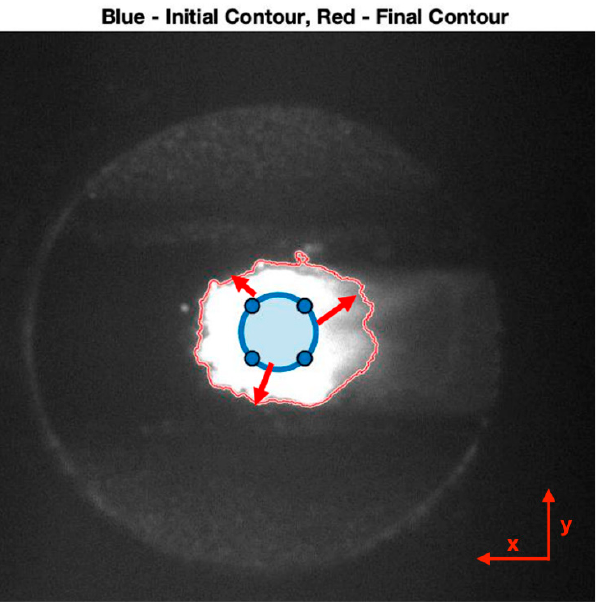
Figure 3. Automated detection of a melt pool edge from a video frame using the active contour algorithm.